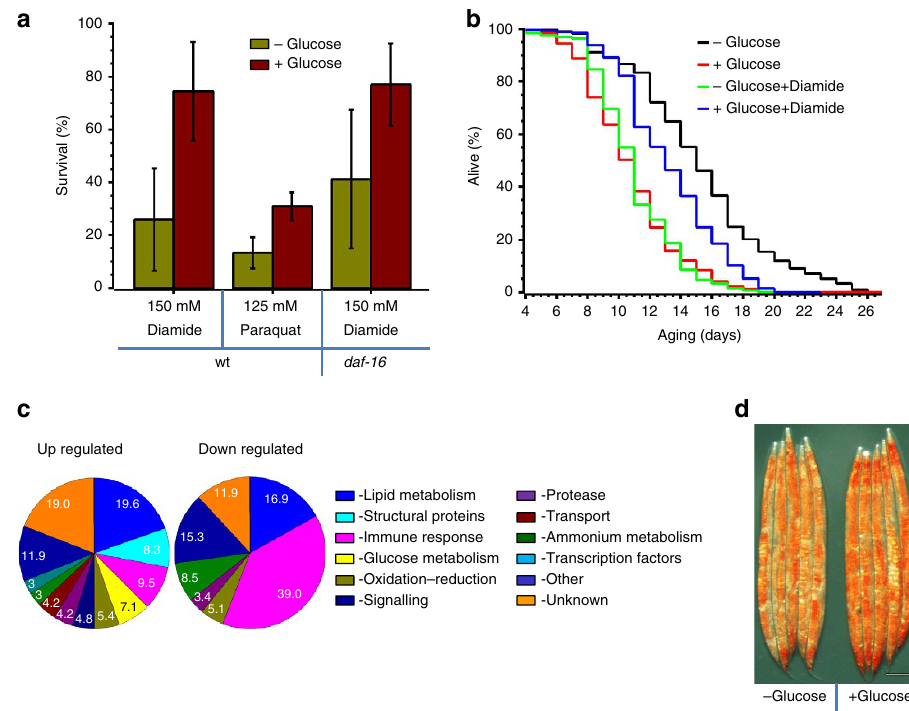
Figure 1 | Dietary glucose protects C. elegans from oxidative stress. ( a ) Dietary glucose protects wt and daf-16 worms against 125mM paraquat ( n ¼ 190, P ¼ 0.0006) or 150mM diamide (wt: n ¼ 170 P ¼ 0.0057; daf-16 : n ¼ 140, P ¼ 0.0284). L4 stage worms were placed on NGM plates with sorbitol (green) or glucose (red) for B 20h at 20 (cid:2) C and then treated with the indicated oxidants. To compensate for glucose-induced osmolarity, sorbitol (a non-digestible sugar) was added to the diet of a control group. Graph shows the average survival ± s.d. from three independent experiments. Approximately 50